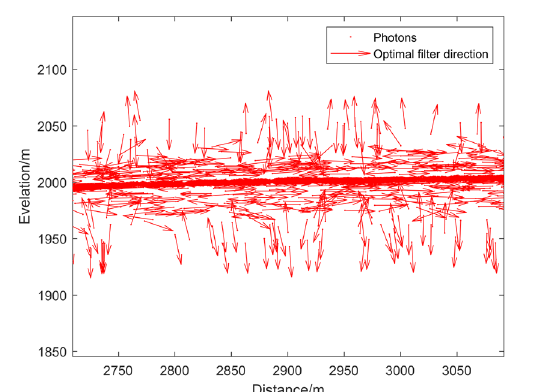
Figure 4 . Optimal filter direction. A segment cut from the